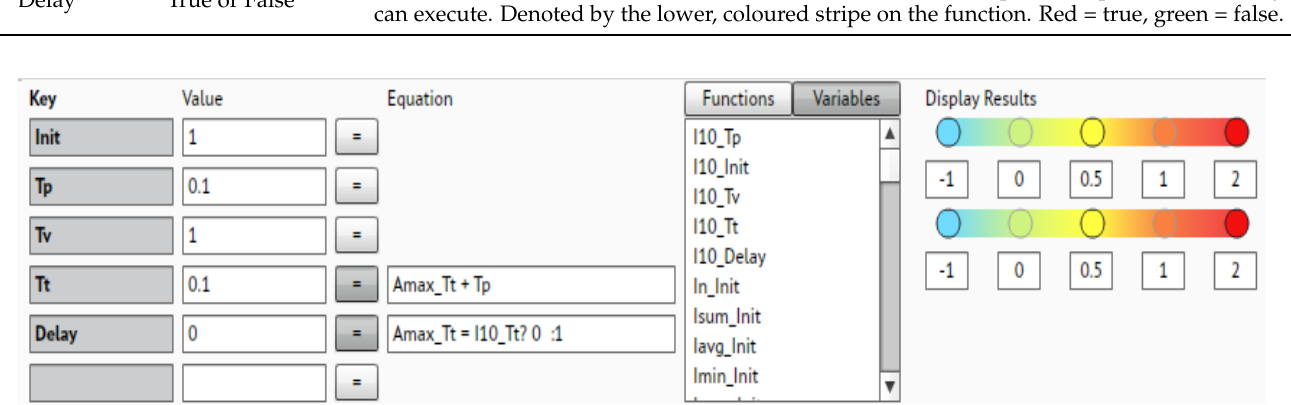
Figure 6. The metadata keys and values. Table 2. Key–value pairs for the ‘work as imagined’ FRAM.